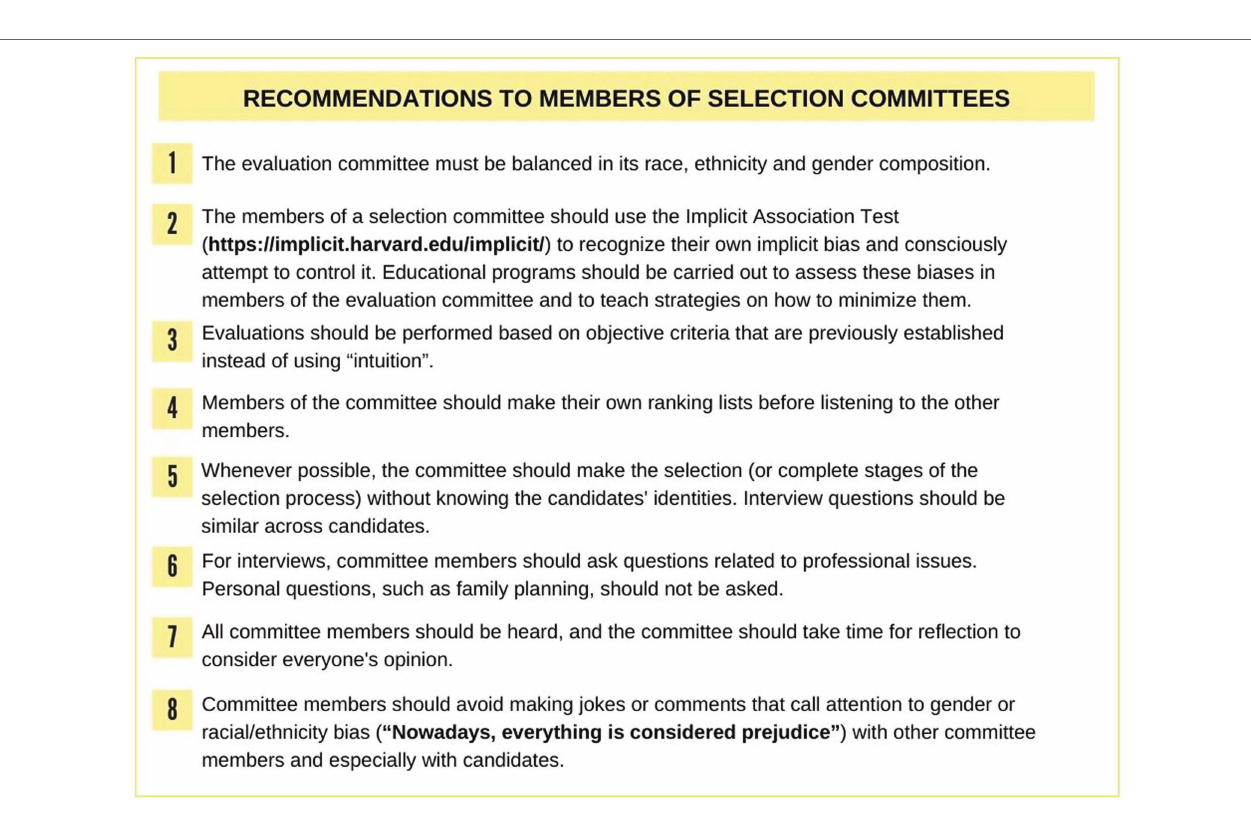
FIGURE 3 | Suggestions for people in positions of power within selection